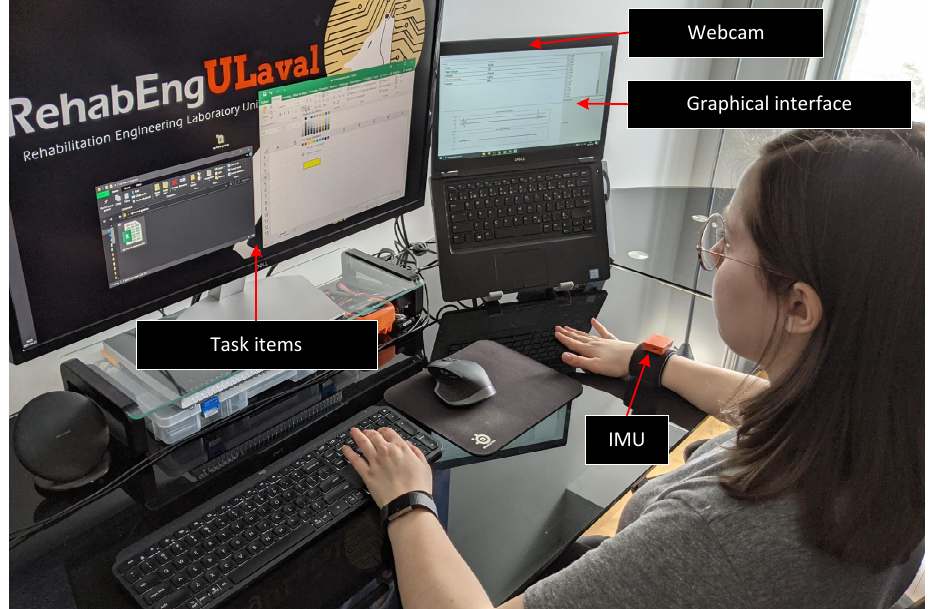
Figure 10. Experimental setup for the hand gesture interface